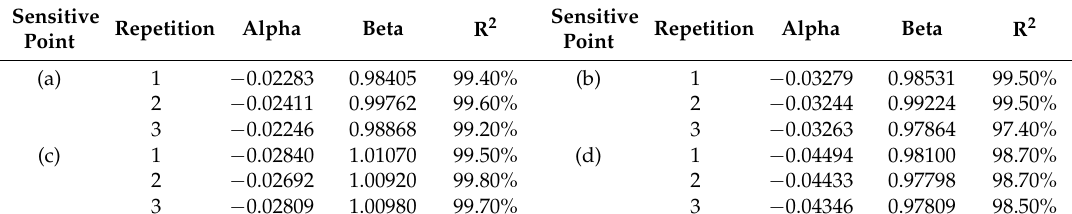
Figure 7. The plots represent the response of four different points to an increasing static load. The measurements were repeated three times and plotted with different colors. The linearity for the single measurement was evaluated, the results are reported in Table 2: ( a , c ) side points tested on the cover sample; ( b , d ) central points tested on the cover sample. Table 2. Results of the linear regression for the loading static test. The alpha is the first-degree term of the linear regression, the beta is the constant term. The R 2 values are reported in the third columns.